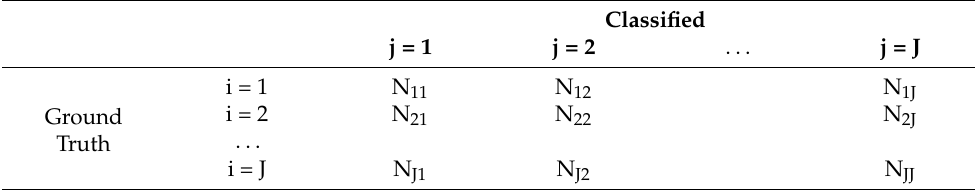
Table 4. The typical error confusion